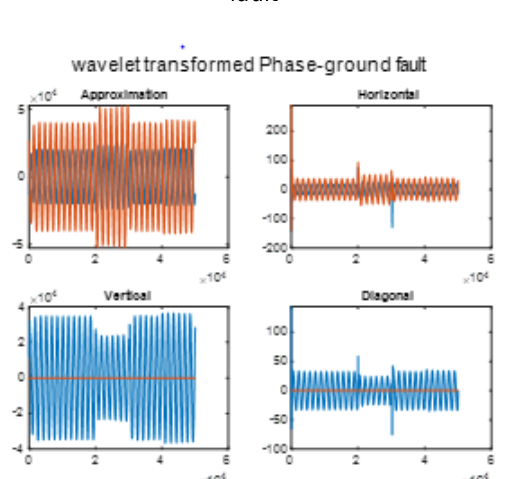
Figure 10. Simulation: wavelet Transform for line-line